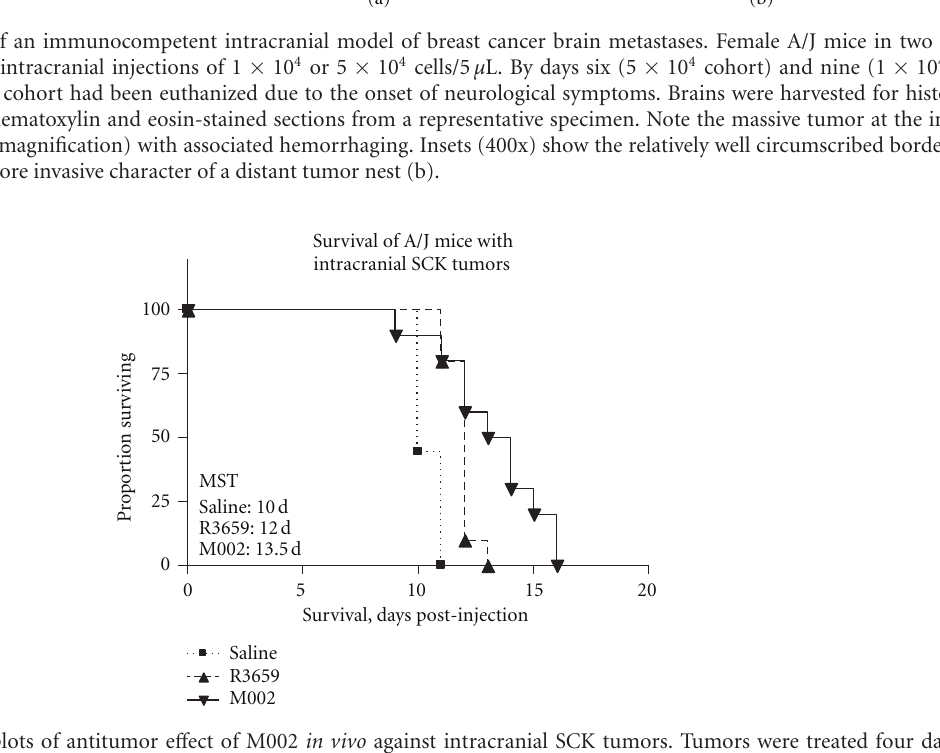
Figure 6: Kaplan-Meier plots of antitumor e ff ect of M002 in vivo against intracranial SCK tumors. Tumors were treated four days after establishment with 1.5 × 10 7 PFU of R3659 or M002, or were given saline only as a control. By log-rank analysis, both R3659-( P = 0 . 0004) and M002-treated mice ( P = 0 . 0012) survived significantly longer than mock-treated mice, and M002-treated mice survived longer than R3659-treated mice ( P = 0 . 0333). Median survival times (MSTs) are